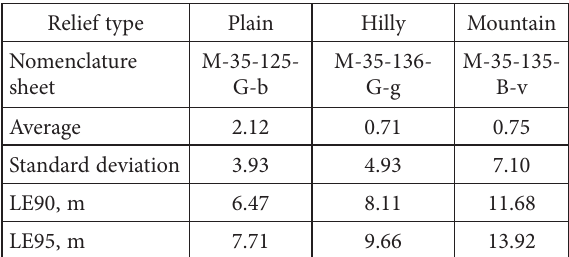
Table 1. The statistical parameters of map’s height difference DTM by topographical maps and matrix data SRTM and ASTER Scale Relief type Plain Hilly Mountain Plain Hilly Mountain Plain Hilly Mountain Height